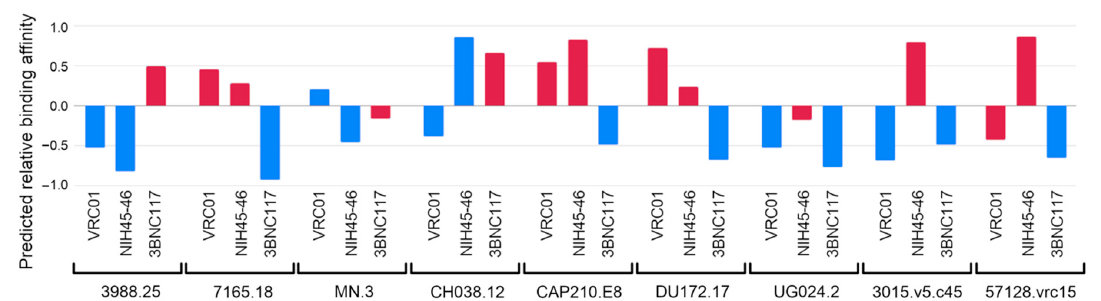
Figure 6. Predicted relative binding affinities of 9 different HIV-1 gp120 strains towards VRC01, NIH45-46 and 3BNC117 using PELE simulations. Most of the sensitive strains (blue) are correctly predicted (12 out of 14, negative predicted affinity), while most of the resistant strains (red) are also predicted as such (10 out of 13, positive predicted affinity).